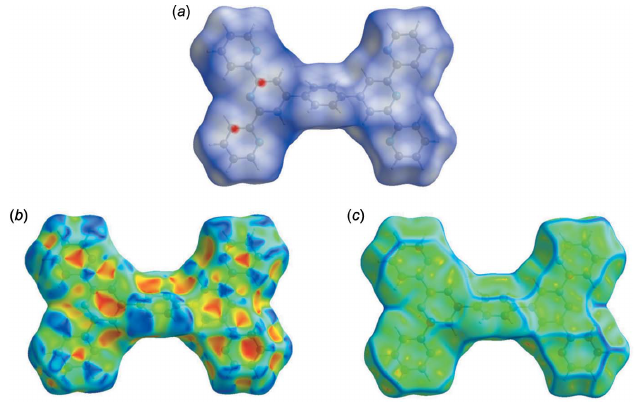
Figure 4 ( a ) The Hirshfeld surface of Form I, mapped over d norm , plotted in the range (cid:4) 0.0541 to 1.3209 a.u., ( b ) the Hirshfeld surface of Form I, mapped over the shape-index and ( c ) the Hirshfeld surface of Form I, mapped over the curvedness.